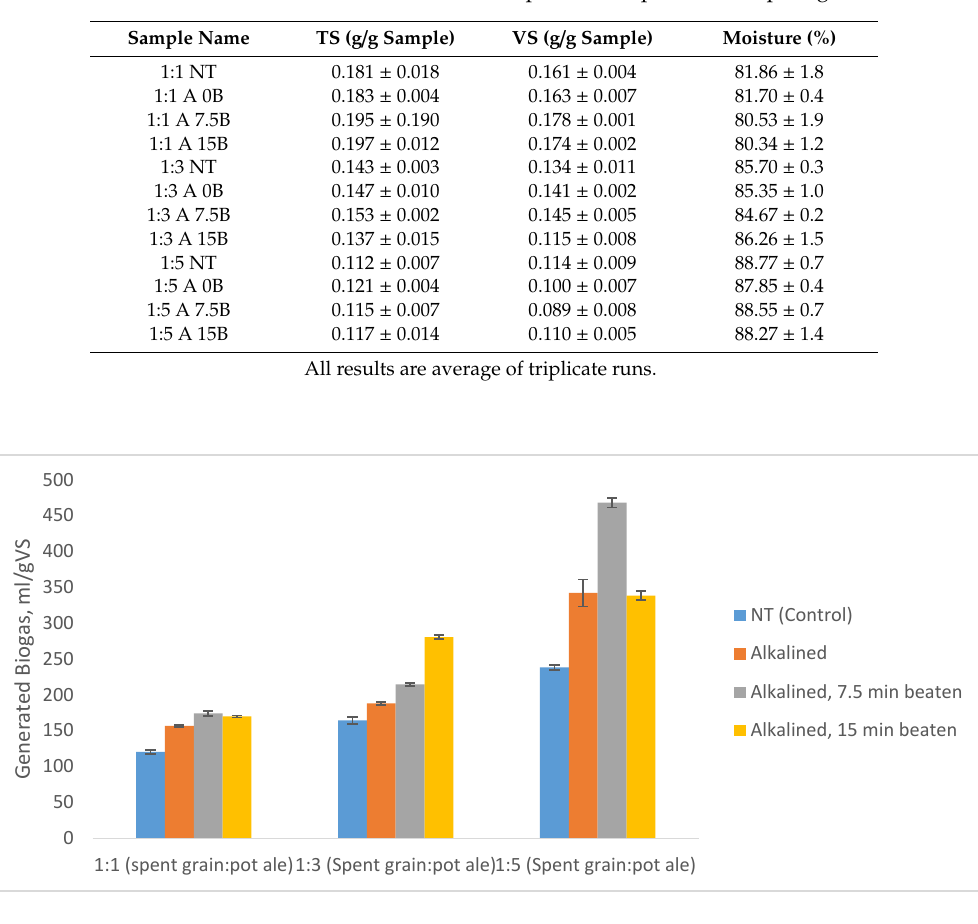
Table 4. TS, VS, and Moisture% of the non- and pre-treated pot ale and spent grain mix.